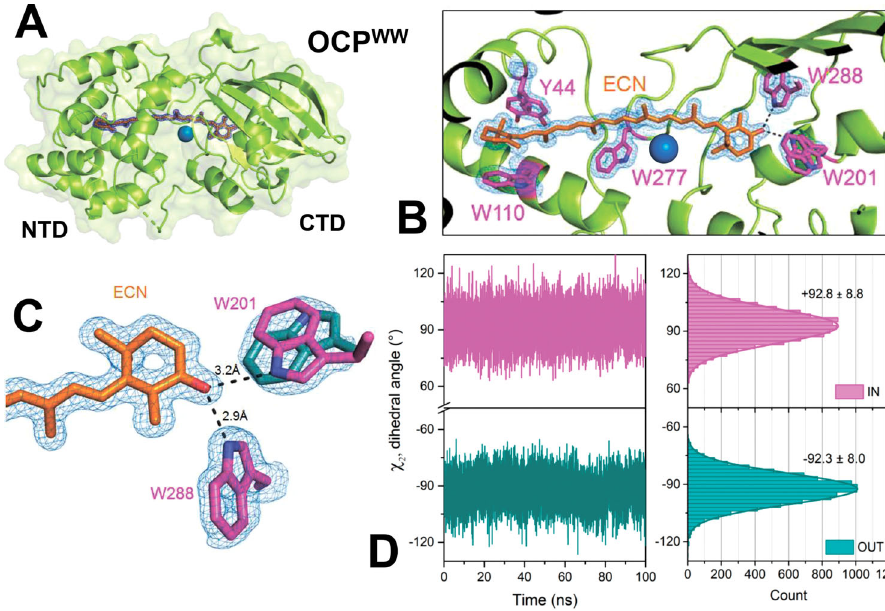
Fig. 2 The most complete, representative crystal structure of the Y201W variant of OCP (OCP WW ), PDB ID 6T6O. A Overall structure of ECN-binding OCP WW shown as a cartoon backbone and a semi-transparent surface. A chloride ion is shown as a blue sphere. B Close-up view on the carotenoid- binding pocket of OCP WW . Crucial amino acids with hydrophobic side chains are shown in purple. Note the alternative positions of Trp-201 and Tyr-44. The other structures determined at different pH values (PDB IDs 6T6K, 6T6M) also reveal two alternative conformations for these amino acids. C Organization of hydrogen bonds between the keto oxygen of ECN and Trp-288/Trp-201. Panels A – C show 2F O -F C electron density maps contoured at 3 σ ( A ) or 1 σ ( B , C ). D Values of the dihedral angle ( χ 2 ) between the peptide backbone and the indole ring of Trp-201 as revealed by MD simulations of OCP WW with different initial conformation of Trp-201 (as shown in panel C : IN – purple, OUT –